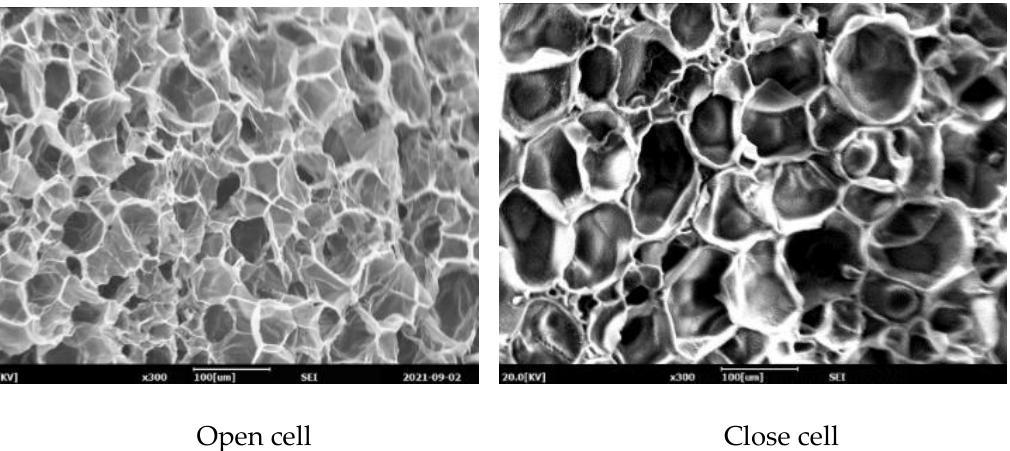
Figure 3. SEM micrographs of P(3HB- co -4HB) with different 4HB content foamed at 90 bar.